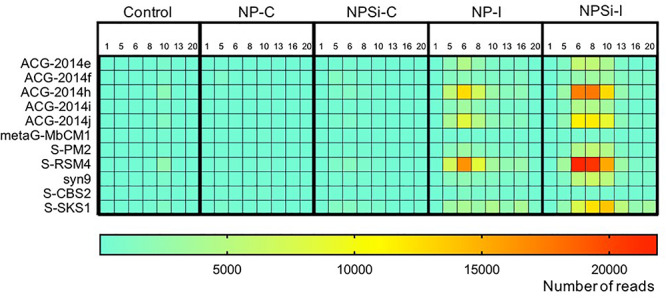
Heatmap showing the number of reads (average values from duplicate mesocosm bags) for the most abundant Synechococcus phages for all treatments, from days 1 to 20.